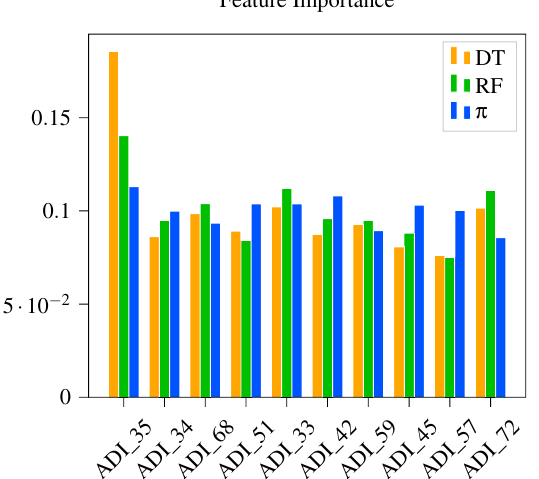
Figure 6. Importance of different items relative to each other according to different model types.